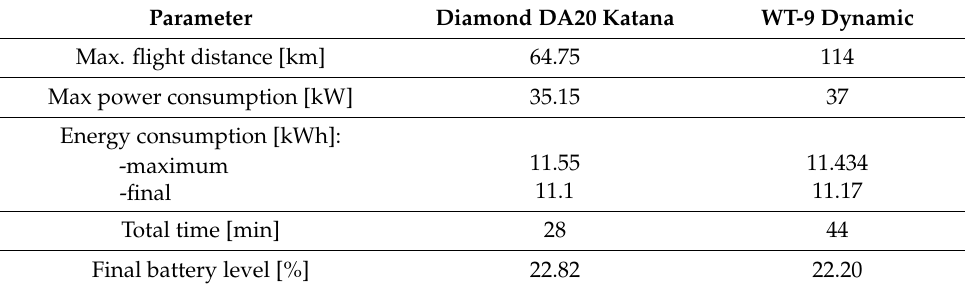
Table 8. Comparison between DA20 Katana and WT-9 Dynamic—cross country flight.